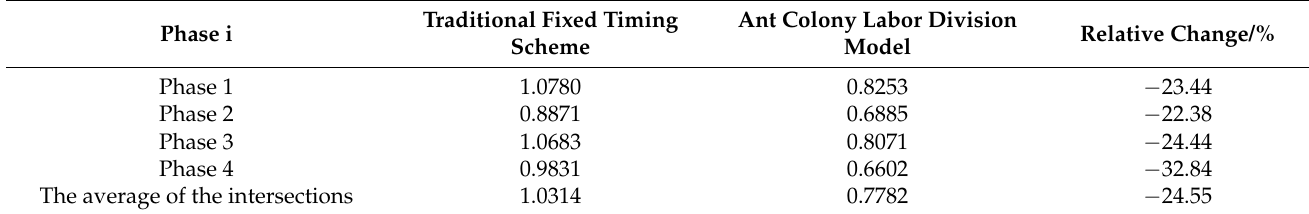
Table 2. Comparison of the average number of stops of vehicles at